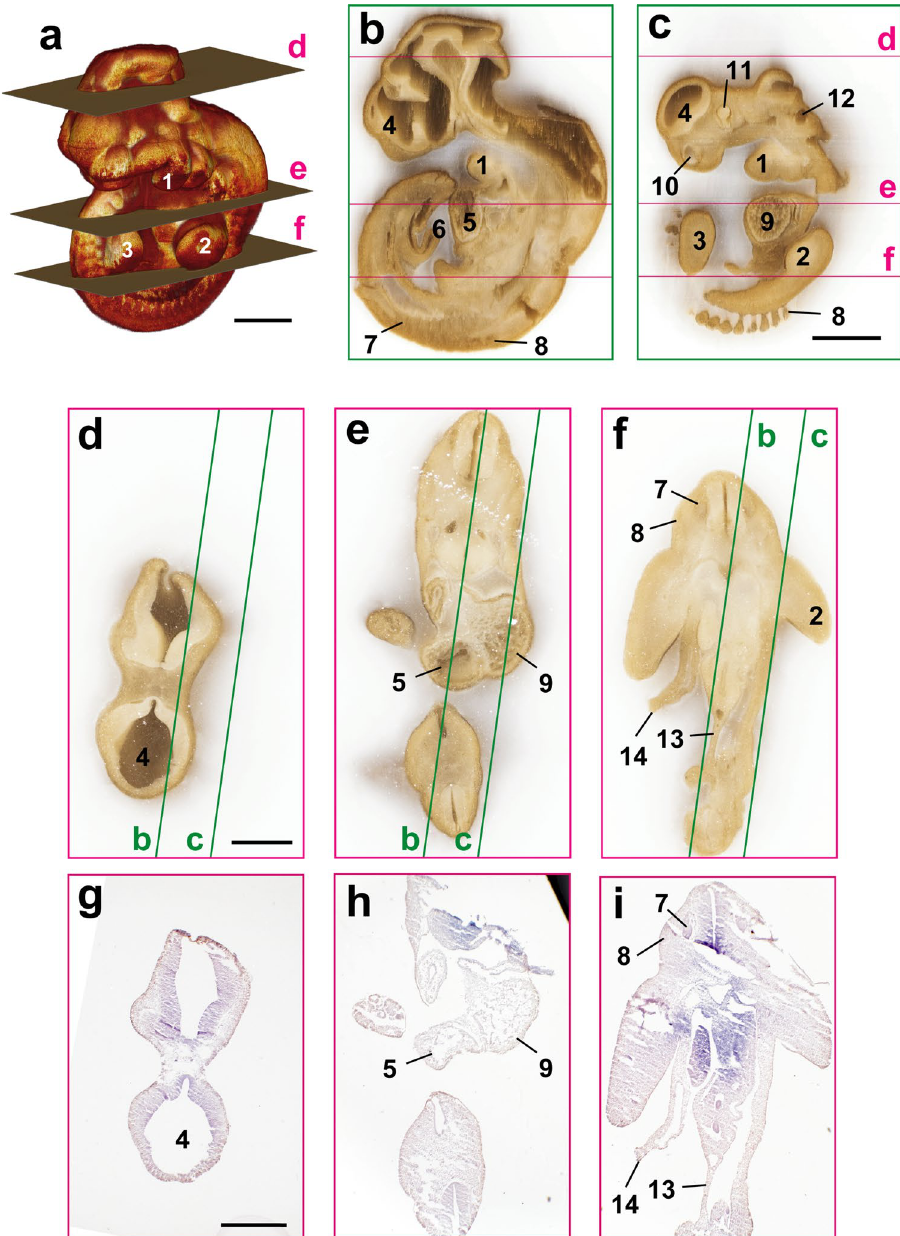
Figure 6. Correlation between 3D image and sections of mouse embryo on E10 in a frozen block. The mouse embryo on E10 was frozen and sliced at a thickness of 10 µm using CoMBI-S system. ( a ) 3D volume-rendered image using 520 block-face images shows the surface structures of the mouse embryo. ( b , c ) The reconstructed sagittal planes. ( d – f ) Three examples of block-face images are shown. Green lines indicated the positions of ( b ) and ( c ). ( g – i ) Sections were collected at the positions of ( d – f ). H&E-stained sections can be correlated with block-face images in ( d – f ), and the positions where the sections were obtained are indicated as planes in ( a ).